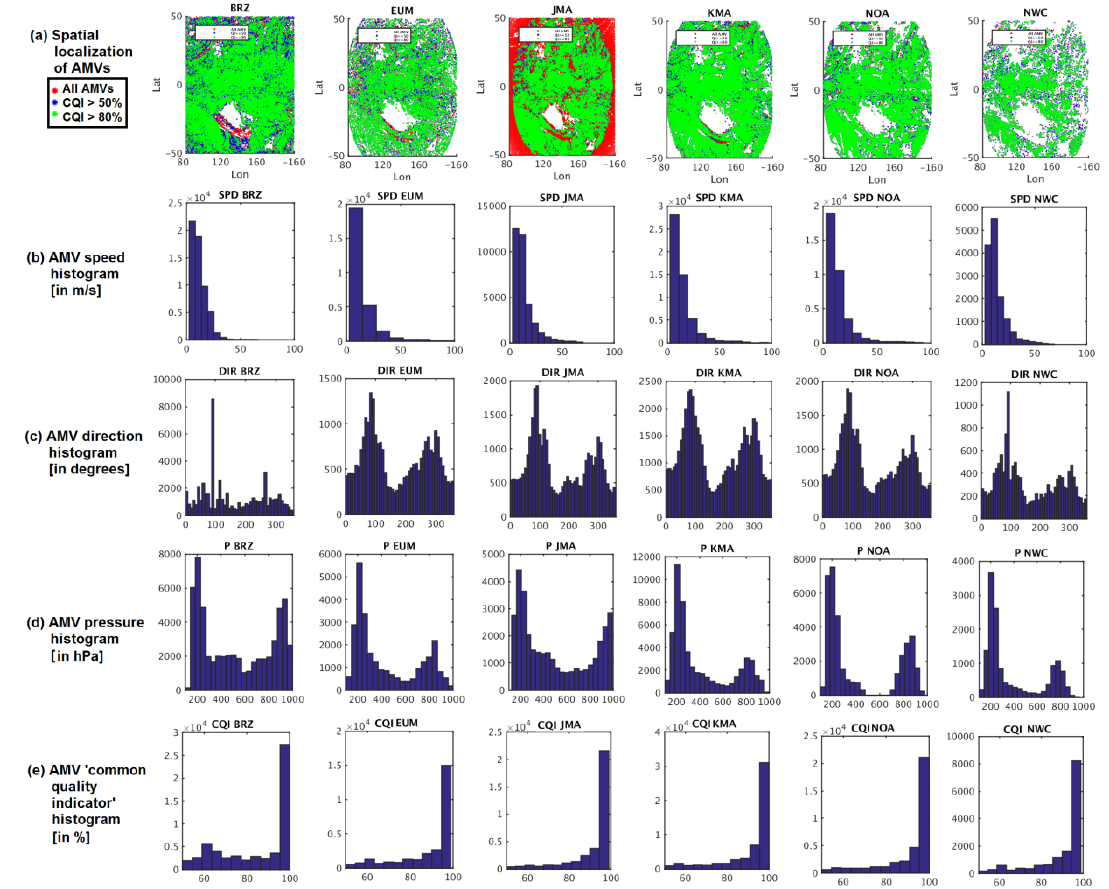
Figure 2. Spatial localization of Atmospheric Motion Vectors (AMVs) ( a ), and histograms of parameters: ( b ) AMV speed in m s − 1 , ( c ) AMV direction in degrees, ( d ) AMV pressure in hPa, ( e ) AMV CQI (Common Quality Indicator) in %, for the AMV datasets in Experiment 1 with CQI >= 50%. From left to right, BRZ, EUM, JMA, KMA, NOA, NWC. BRZ: Brazil Center for Weather Prediction and